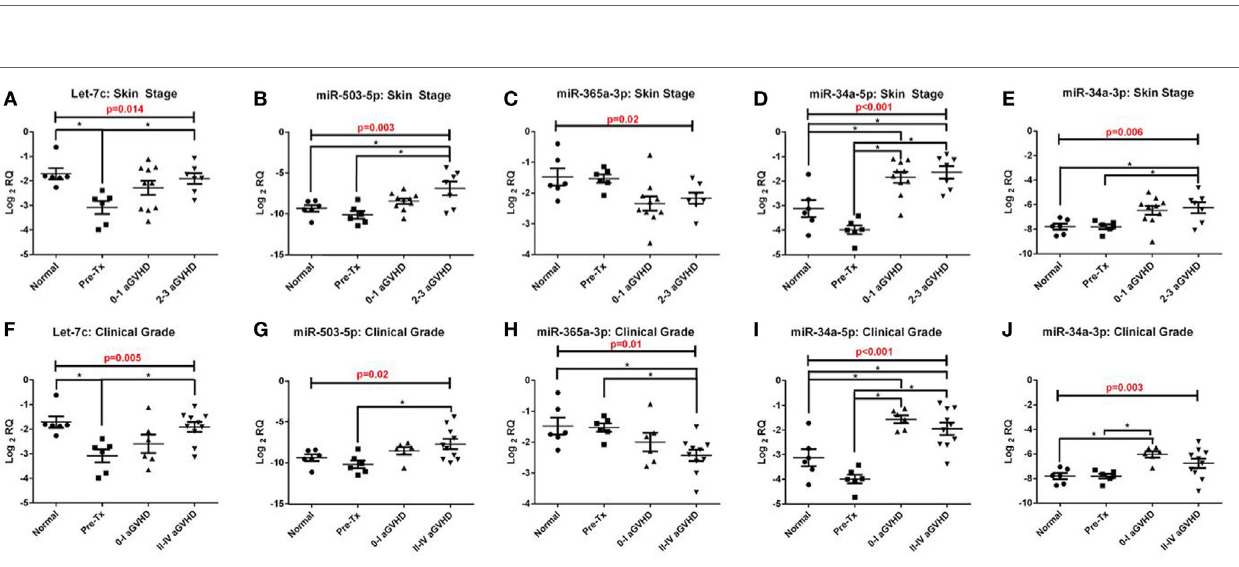
FigUre 1 | Heat map showing skin biopsy discovery cohort global microRNA expression levels. Each row is representative of one microRNA and each column represents one sample. Unsupervised hierarchical clustering analysis was performed using the expression levels from n = 186 detectable microRNAs in the total discovery cohort ( n = 9). The heatmap shows the top 50 microRNAs that were expressed in all 9 samples. The vertical dendrogram indicates three distinct microRNA clusters, based on the expression values in all samples. The scale of the dendrogram shows the distance, representing similarity between clusters. The horizontal dendrogram shows the clustering of samples into two clusters. Normalized log 2 values were used for this analysis. The average linkage method was used for the unsupervised hierarchical clustering of the normalized expression results. Fold change range is from − 5 to 10. Red boxes highlight microRNAs of interest. Over expressed = green cells, intermediate = light purple cells, under-expressed = dark purple cells. Post allo-HSCT samples are also labeled with their histopathological skin aGvHD stage (1–3) and overall clinical aGvHD grade (II–IV). Abbreviations: N, normal healthy control; allo-HSCT, allogeneic hematopoietic stem cell transplantation; aGVHD, acute graft-versus-host